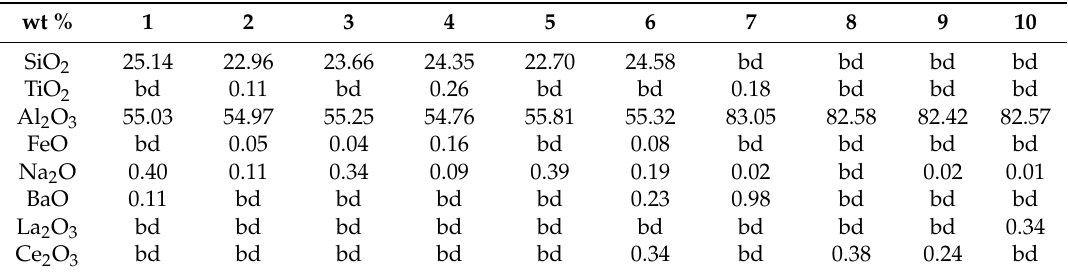
Figure 5. Back-scattered electron images of alteration minerals contained in samples from Konos Hill, NE Greece: ( a ) Euhedral zunyite (Znt) crystals in association with quartz, tabular alunite (Alu + Qz), and hematite (Hem); ( b ) APS included in euhedral zunyite (Znt); ( c ) Diaspore (Dsp) crystals included in an alunite and quartz (Alu + Qz)-dominated matrix; ( d , e ) APS pseudocubic crystals in the core of tabular-shaped alunite; ( f ) Tabular alunite (Alu) in association with quartz (Qtz) and hematite (Hem). Table 1. Representative EPMA data of zunyite (1–6) and diaspore (7–10) from the advanced argillic alteration zone of the Konos Hill prospect, NE Greece.